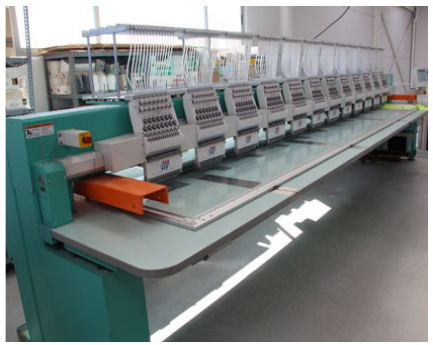
Figure 15. The TMFD-G1215 computer embroidery machine, Tajima.